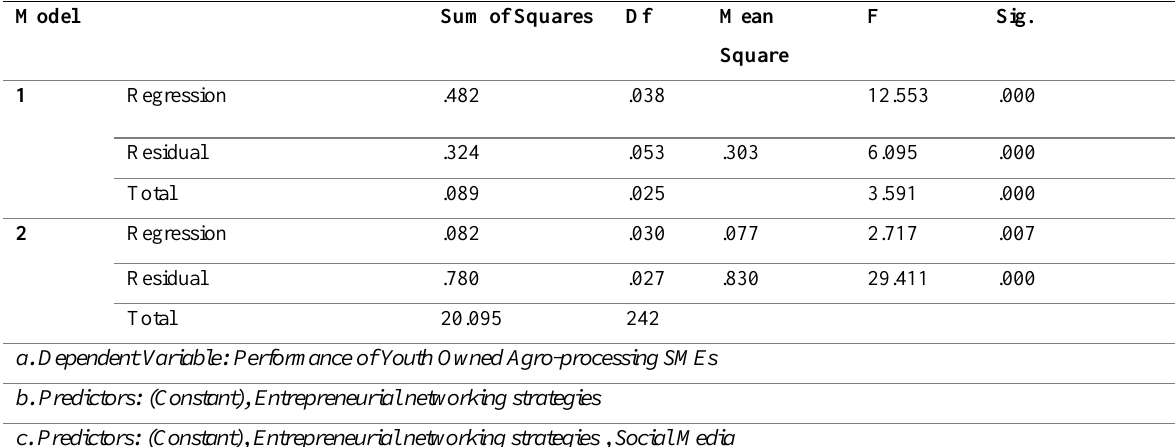
Table 6: ANOVA for Moderating Effect of Social Media on Relationship between Entrepreneurial Networking and Performance Model Sum of Squares Df Mean